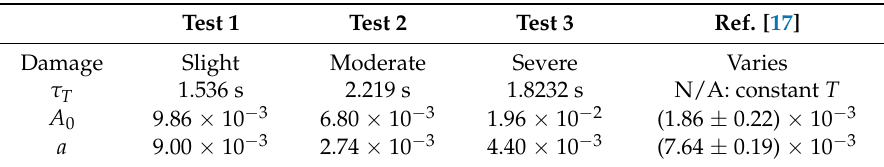
Table 4. ICC Fit Parameters for Tests